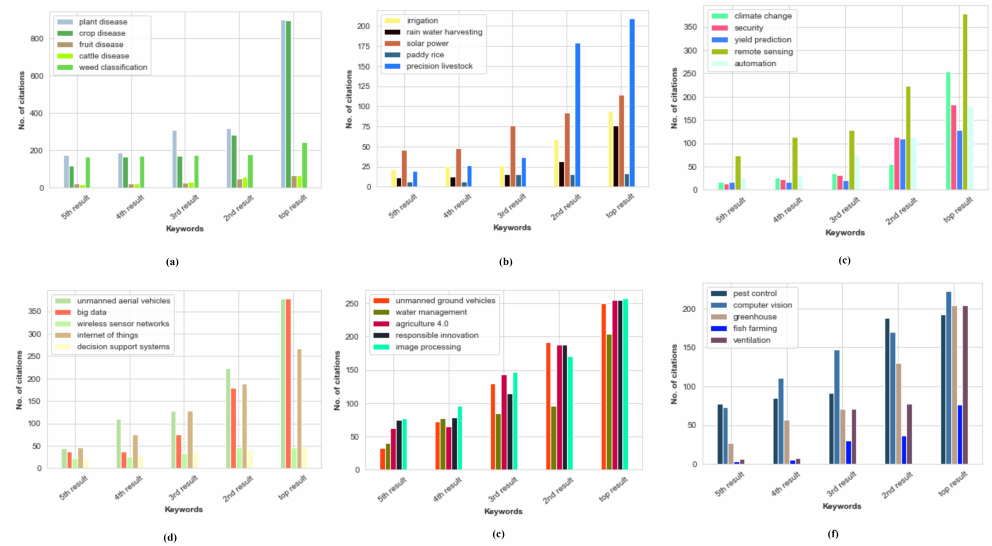
Figure 1. Number of citations per keyword for each of the 6 groups ( a – f ) of 5 closely related keywords. The number of citations are compared for the top 5 search results.